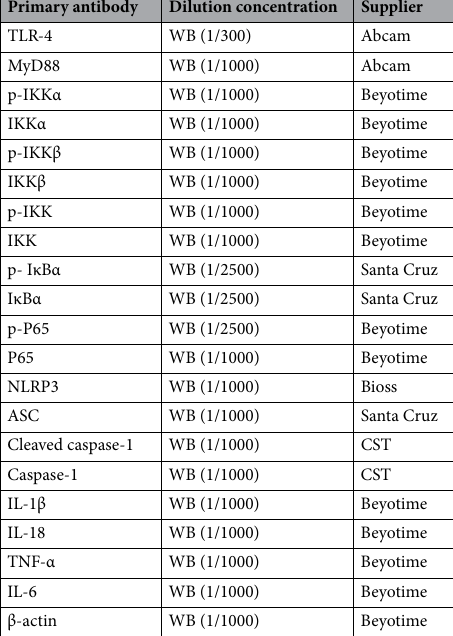
Table 1. Antibodies for immunofluorescence staining and western blot. WB western